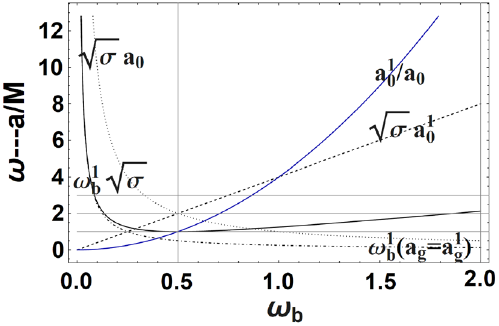
(ω) from Eq. (33), the dashed curve is Fig. 9 Th black curve is ω 1 √ b σ for equal ( a ,σ) of Eq. (30), the blue curve is a 1 a 0 (ω b ) g equal ( a g ,σ) from Eq. (30), the dotted curve is for a 0 ( a ,σ) of Eq. (30), the dotted-dashed curve is ω 1 g ) = a 1 (ω a g (ω 1 b g b